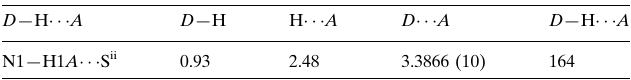
Hydrogen-bond geometry (A˚ , (cid:3)